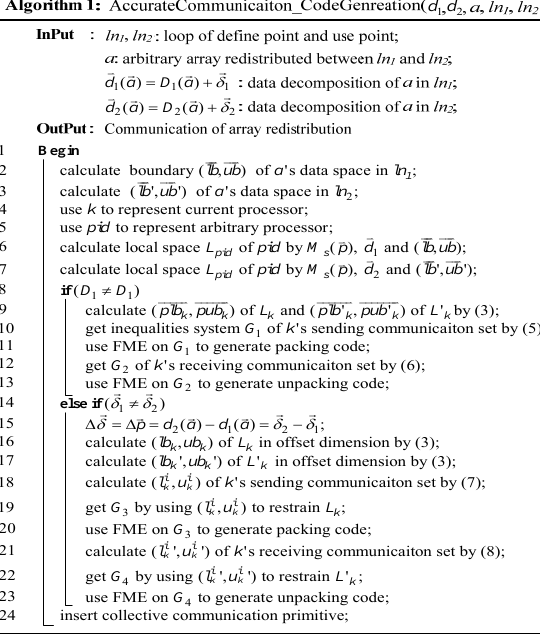
Figure 14. Codegen algorithm of array